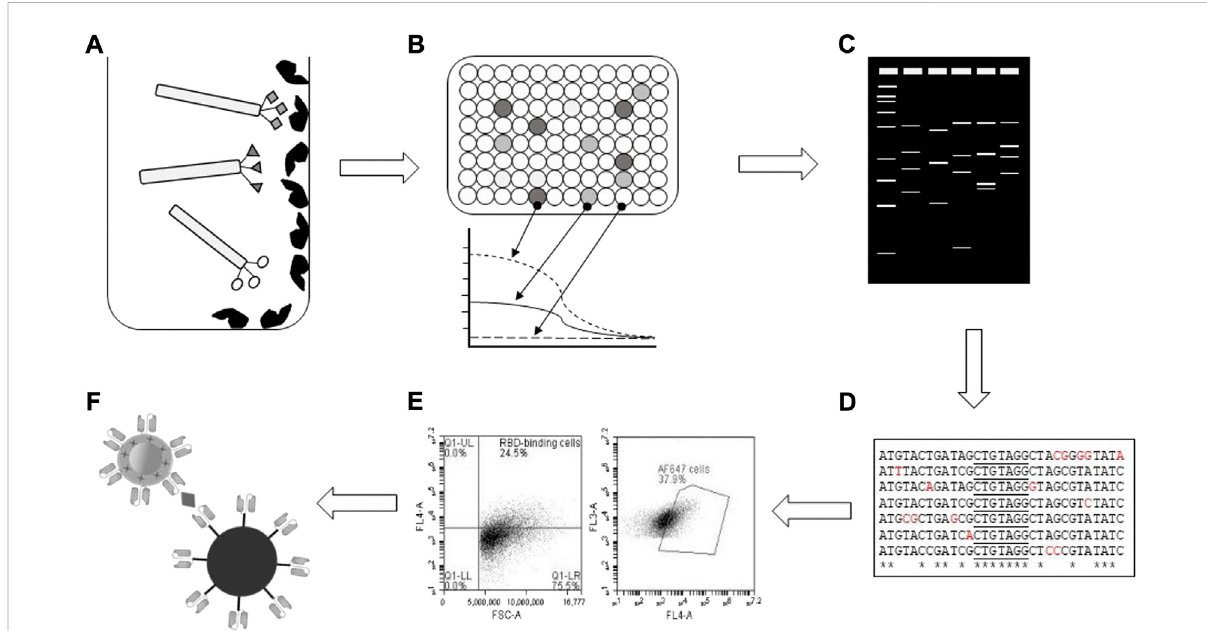
FIGURE 1 Schematic of experimental work fl ow. (A) RBD-binding bacteriophage-scFvs were selected based on binding to immobilised RBD in vitro , followed by (B) ELISA con fi rmation of binding and EC 50 determinations. (C) Restriction pro fi ling of isolated RBD-binding clones identi fi ed unique patternsfor (D) DNAsequencingandbioinformaticanalysis. (E) Flowcytometryscreeningidenti fi edscFvswhichblockedRBDinteractionwithACE2- expressing Vero E6 cells, with (F) screening for binding to variant spike proteins carried out by immunocomplex formation and SERS Raman spectroscopy.